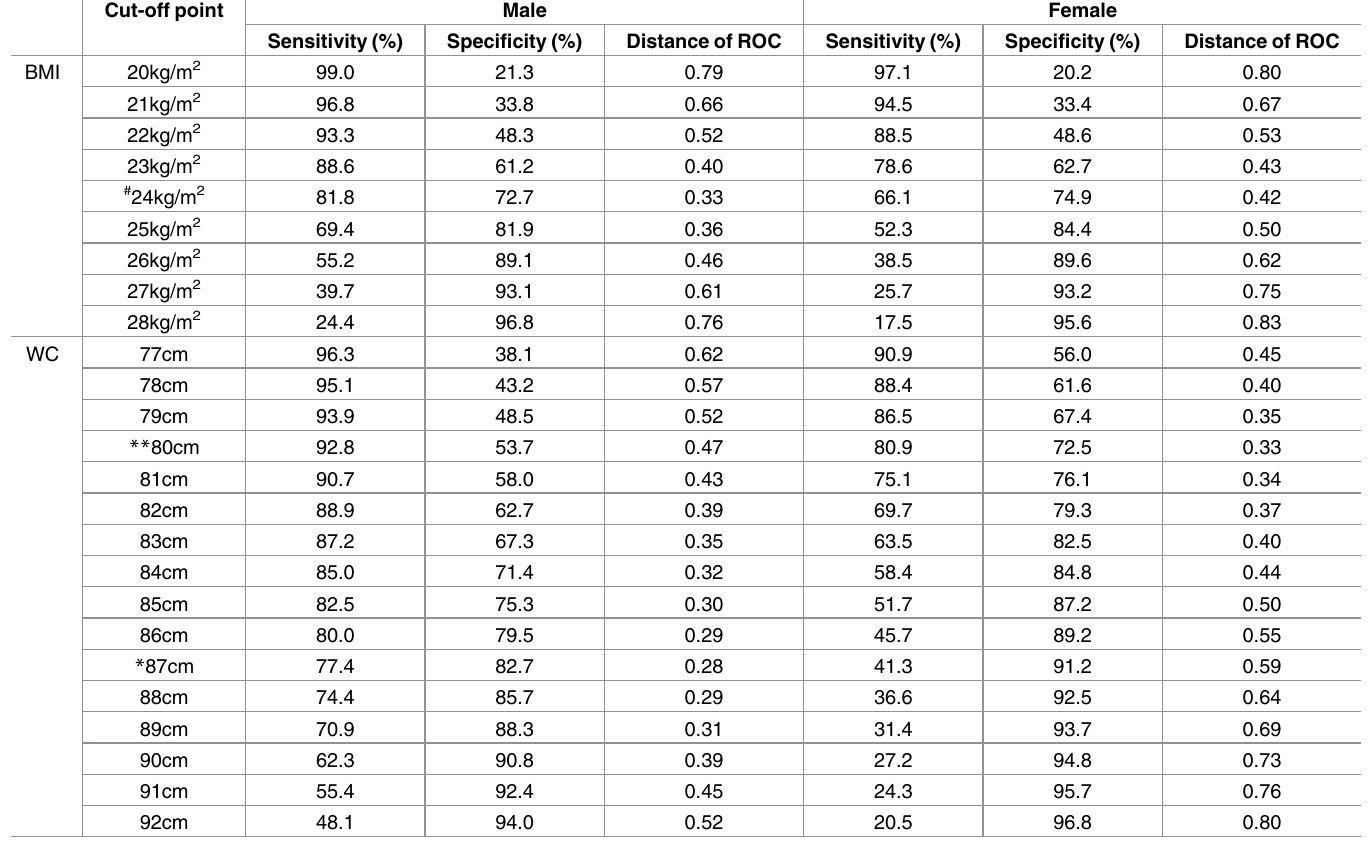
Table 6. Clustering of risk factors for MS predicted by cut-off point of WC and BMI. Cut-off point